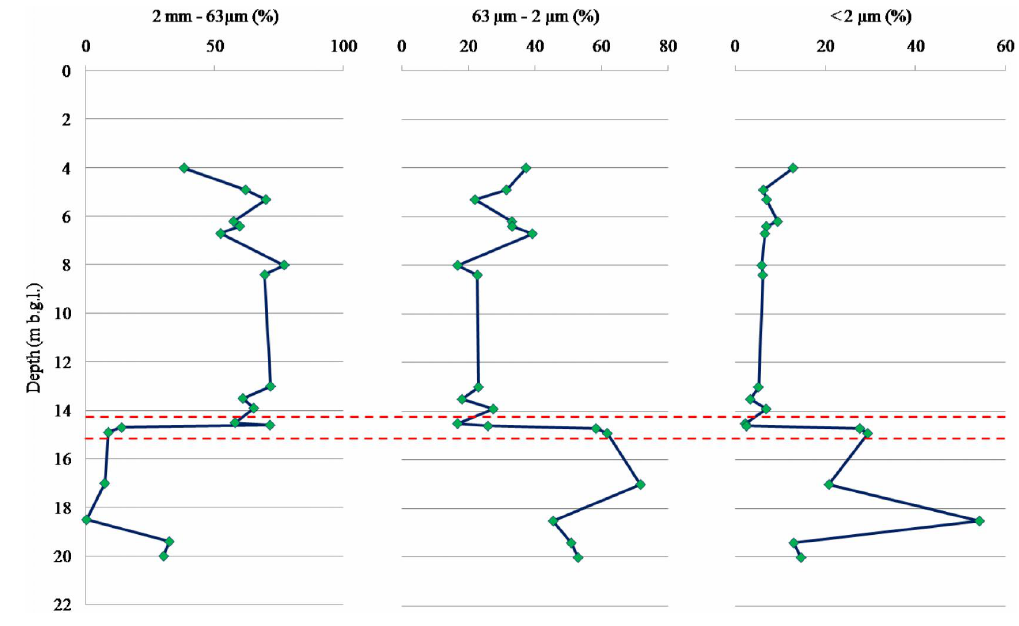
Figure 5. Trend of grain size variation with depth.